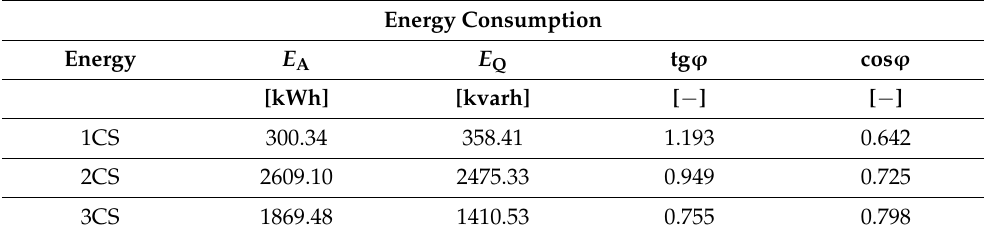
Figure 13. Three-phase reactive power as a function of time on a representative day of the 2nd stage.